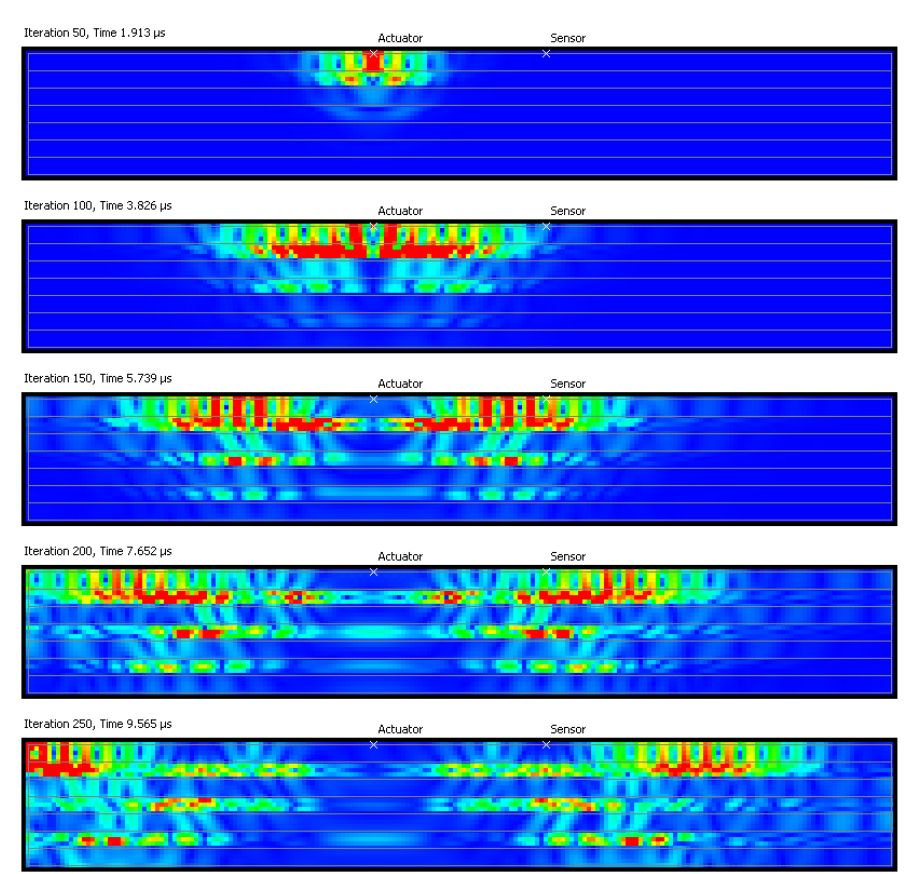
Fig. 7. Displacement vector magnitude in the 2D wave model of the composite plate after 50, 100, 150, 200, and 250 iterations (time steps).